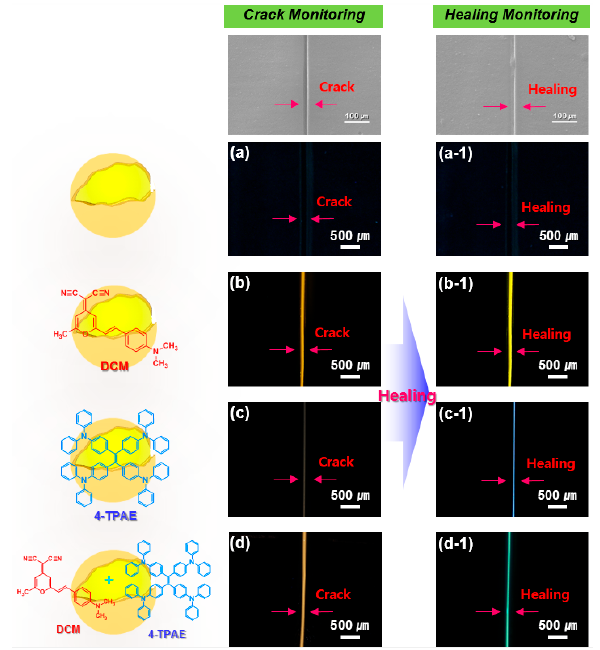
Figure 5. Photographs under 330–385 nm UV source of scratched and healing regions of ( a , a-1 ) a control coating without microcapsules, with ( b , b-1 ) DCM-loaded microcapsules, with ( c , c-1 ) 4-TPAE-loaded microcapsules, and with ( d , d-1 ) 4-TPAE / DCM mixture-loaded microcapsules in self-healing